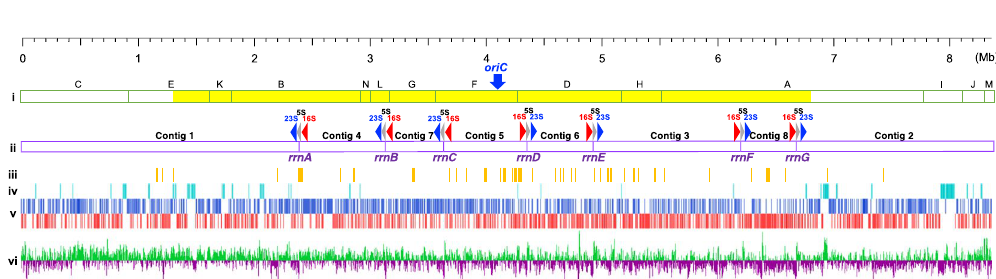
Figure 2. Schematic representation of the S. rochei chromosome. Scale bars are drawn in megabases. ( i ) Ase I physical map. The possible core region of the S. rochei chromosome (1.31–6.80 Mb) is marked as yellow. ( ii ) Distribution of rRNA-encoding gene (rDNA) operons and eight assembled contigs. Gray and blue arrows are 5S-23S rDNA operon, while red is 16S rDNA. ( iii ) Distribution of tRNAs. ( iv ) Distribution of secondary metabolite gene clusters. ( v ) Distribution of CDSs according to direction of transcription ( + strand, upper line; − strand, lower line). ( vi ) GC-skew for 10-kb window and 500-bp step. The putative oriC (gene) locus is indicated by a blue arrow. Main features were generated by DNA plotter software (https://www.sanger.ac.uk/ science/tools/dnaplotter) 15